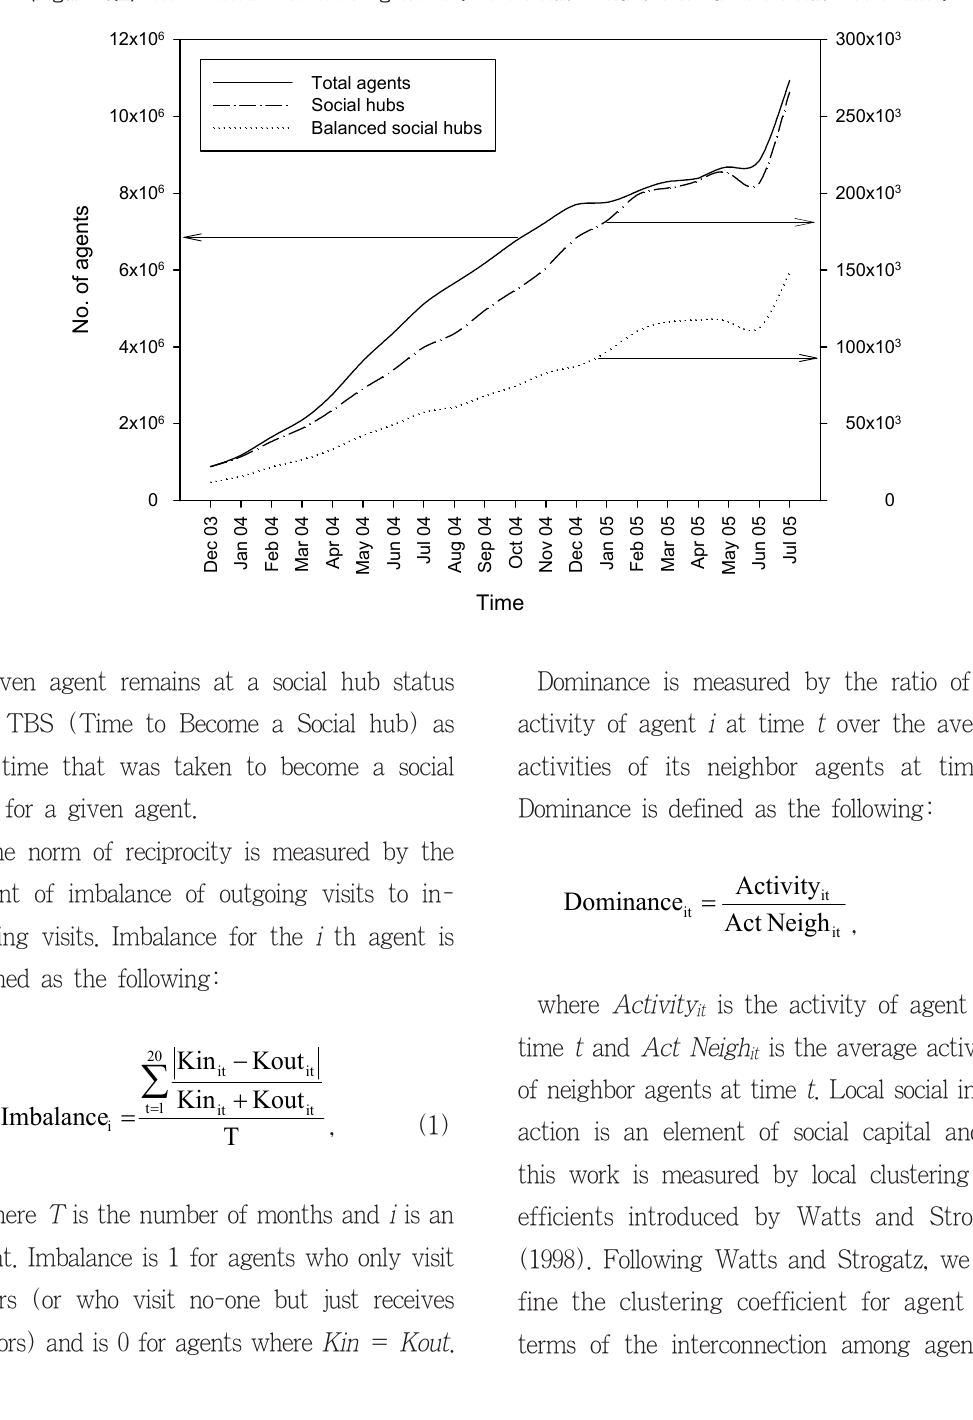
<Figure 3.2> The activities of total agents vs. social hubs and balanced social hubs over